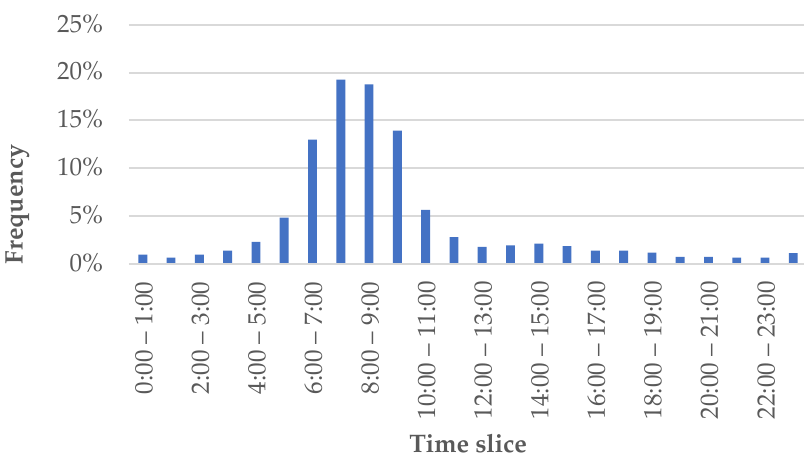
Figure 2. Tour pattern.